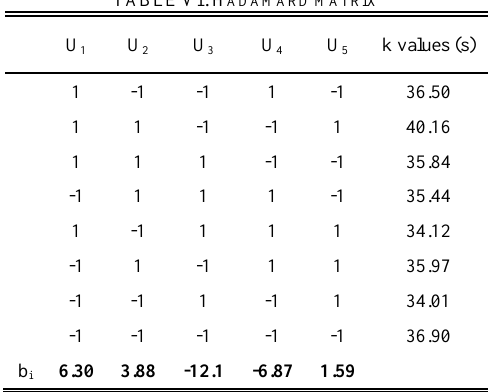
TABLE VI: H ADAMARD MATRIX